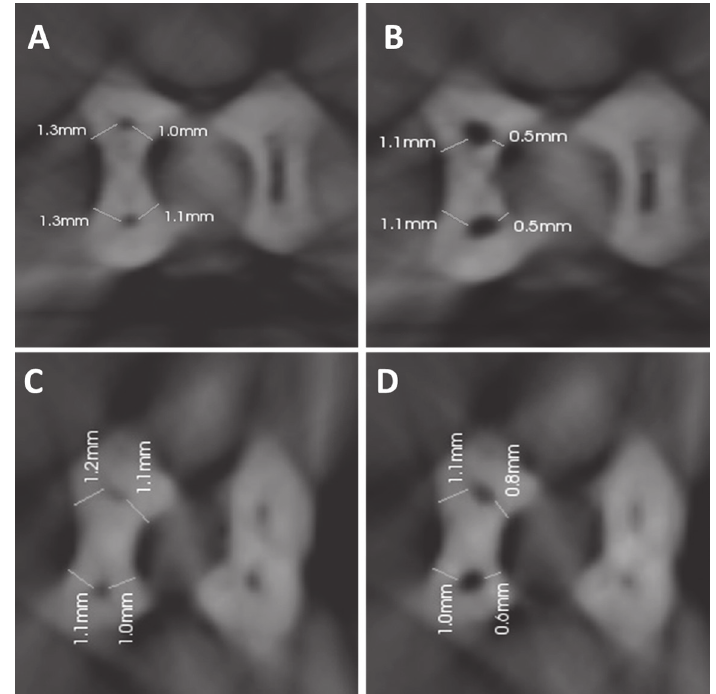
Figure 2- A) Example of a preoperative image in the Gates-Glidden group; B) Postoperative image in Gates-Glidden group; C) Example of a preoperative image in TripleGates group; D) Postoperative image in TripleGates group